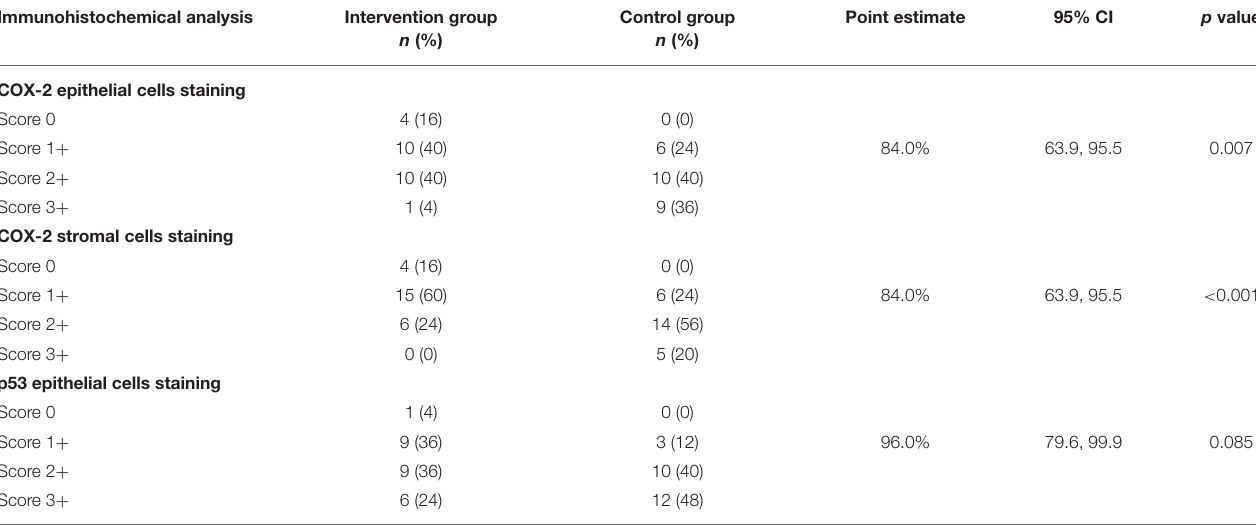
TABLE 2 | Association of cyclooxygenase-2 (COX-2) and p53 expression in excised pterygium tissue between intervention and control groups post-intralesional injection of ranibizumab. Immunohistochemical analysis Intervention group